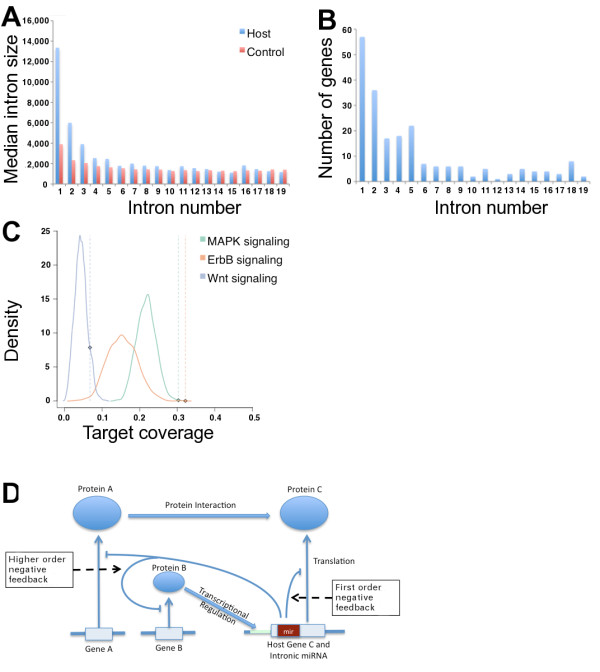
Intragenic miRNA Properties. (a) The sizes of host gene introns closest to the TSS are significantly larger than those of respective controls. (b) Intronic miRNAs appear to be unevenly distributed across the intronic regions of their host genes. More then half of intronic miRNAs are located within the first five 5' introns of their hosts. (c) The observed target coverage (diamond) is at the upper end of the random distribution of target coverages for different signaling pathways, indicating that intragenic miRNAs have more targets within the pathway than would be expected by chance. (d) Intragenic miRNAs may control their host in the setting of a negative feedback circuitry not only through direct regulation of the host's transcription, but also on the order of the interactome, by controlling other genes in the host's pathway.